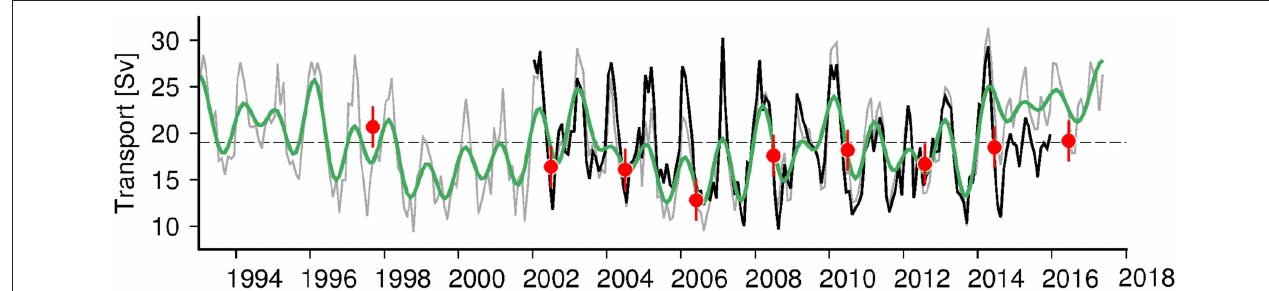
FIGURE 6 | A time series of AMOC transport ( MOC ρ ) at the OVIDE section (eastern subpolar gyre: Portugal to Cape Farewell) for 1993–2017, constructed from altimetry and hydrography. The gray line is from altimetry combined with a time-mean of Argo velocities; the green curve is low-pass filtered using a 2-year running mean. The black curve is from altimetry and Argo. Red circles are estimates from OVIDE hydrography with associated errors given by the red lines. The mean of the gray curve is given by the black dashed line (Updated from Mercier et al.,